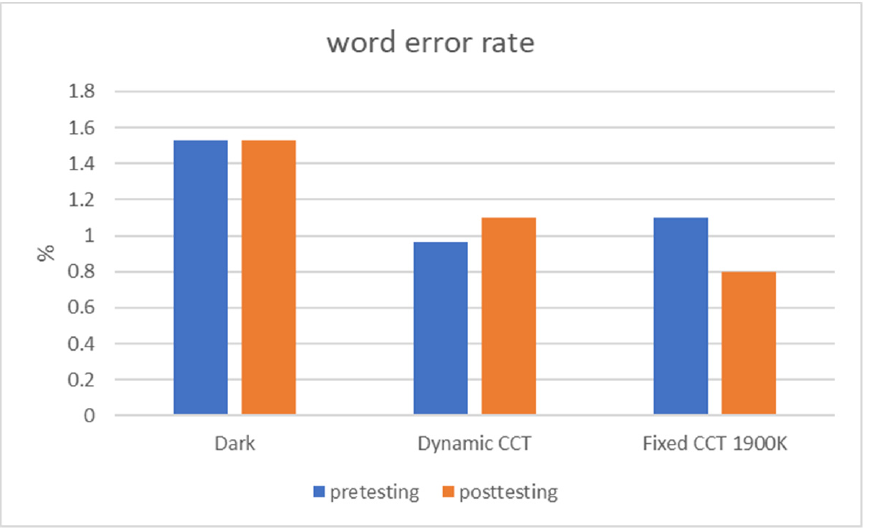
Figure 28. Typing test error rate analysis.